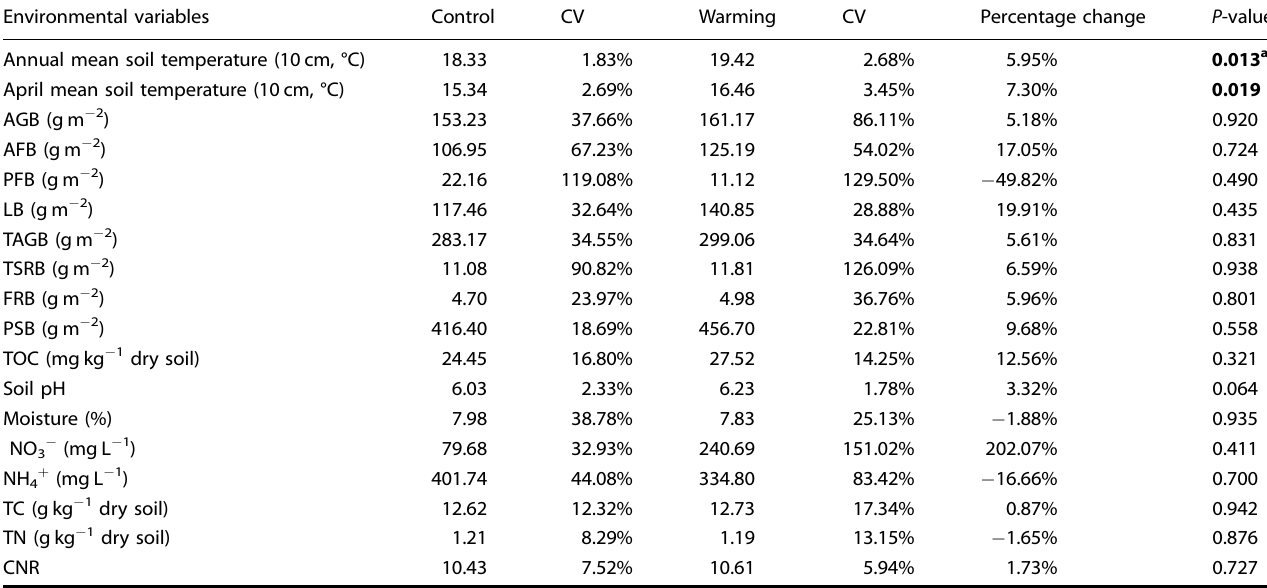
Table 1. The mean values and coef fi cient of variation (CV) of environmental variables in warmed and control samples ( n = 4). Environmental variables Control CV